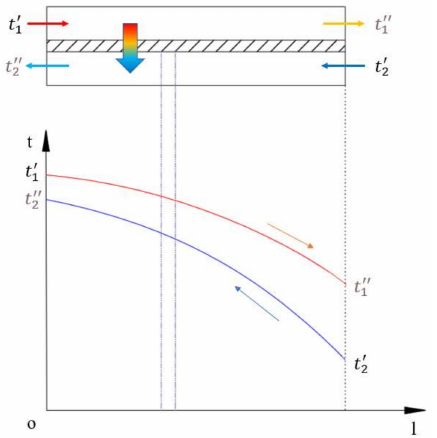
Figure 2. Heat transfer principle of shell and tube heat